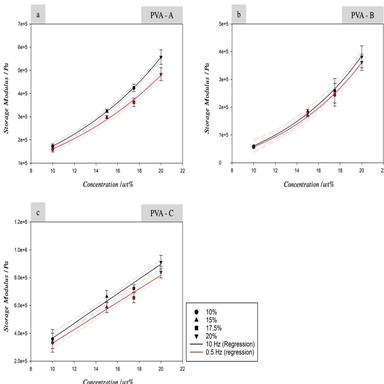
Storage Modulus plotted against concentration for 0.5 Hz (red), and 10 Hz (black) for PVA-A (a), PVA-B (b), and PVA-C (c). Error bars show 95% confidence (n = 6). Regression lines for 0.5 Hz (red), and 10 Hz (black) are also given; dashed lines show 95% confidence intervals for regression. (For interpretation of the references to colour in this figure legend, the reader is referred to the web version of this article.)